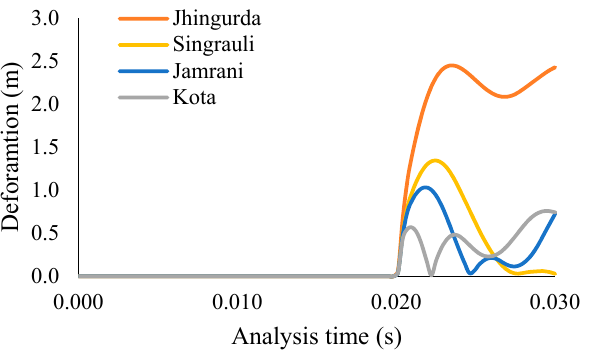
Figure 5. Variation in deformation with time to compare the ground surface behavior under impact loading of 100 kg missile .